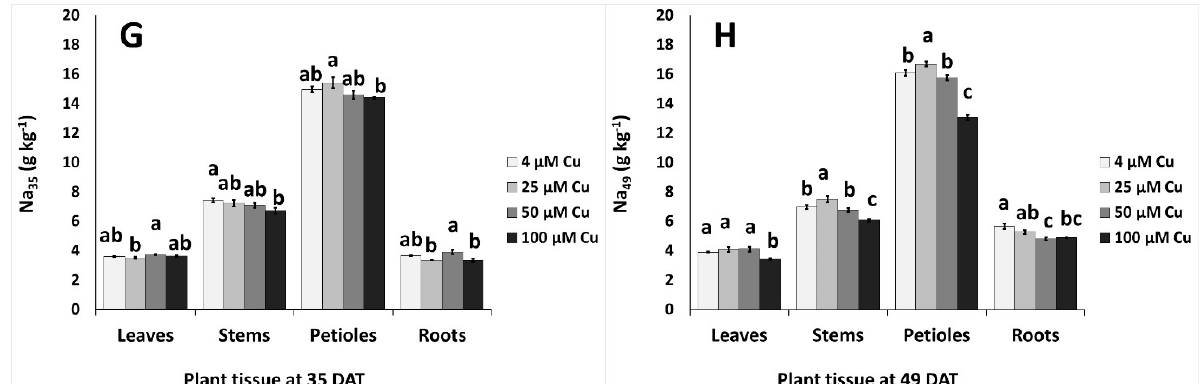
Figure 4. Effect of increasing copper (Cu) concentration (4–25–50–100 μ M Cu 2+ ) in the nutriment solution and sampling date after transplanting (DAT, 35 days and 49 days) on the content of macronutrients and sodium in different organs of pelargonium plants grown hydroponically in perlite. ( A,B ) Nitrogen–N, ( C,D ) potassium–K, ( E,F ) phosphorus–P, ( G,H ) sodium–Na. Significant differences ( p < 0.05) among Cu concentrations at each sampling date are indicated by different letters; ns indicates non-significant. Error bars show SE ( n = 4).